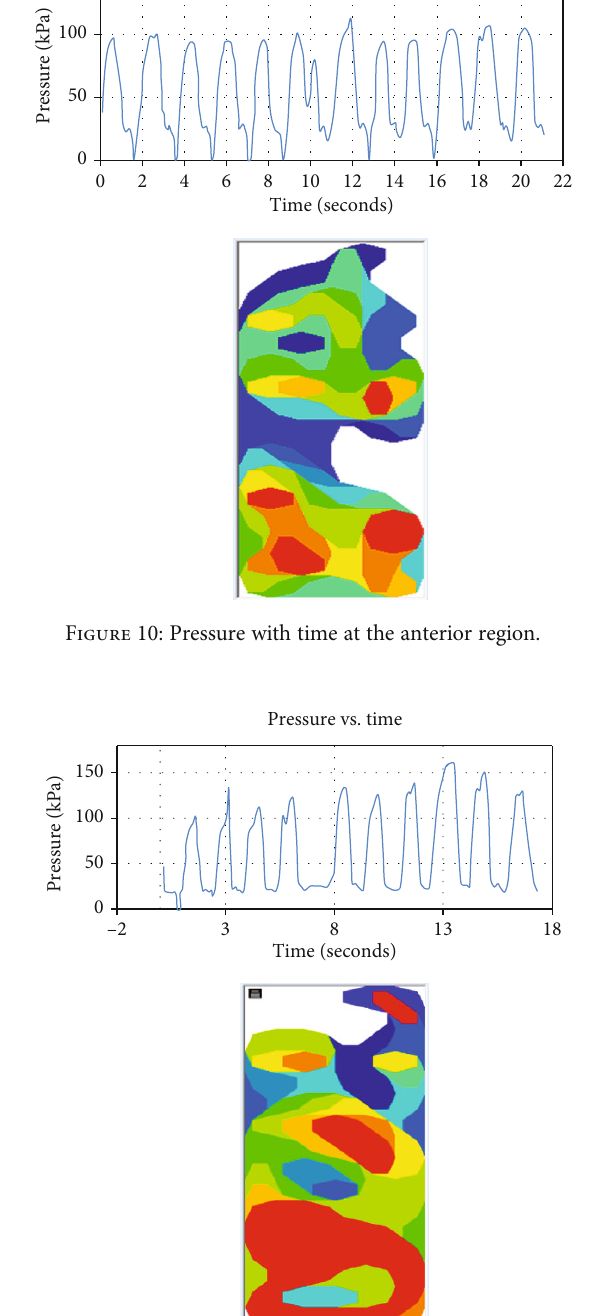
Table 1: The groups of lamination. No.